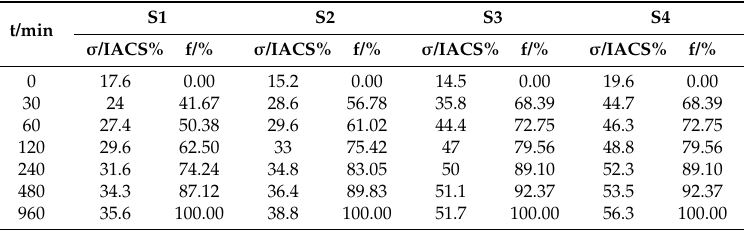
loys aged at 450 °C for multiple periods of time . Table 2. The electrical conductivity and new phase volume transformation ratio of precipitate for alloys aged at 450 ◦ C for multiple periods of time.